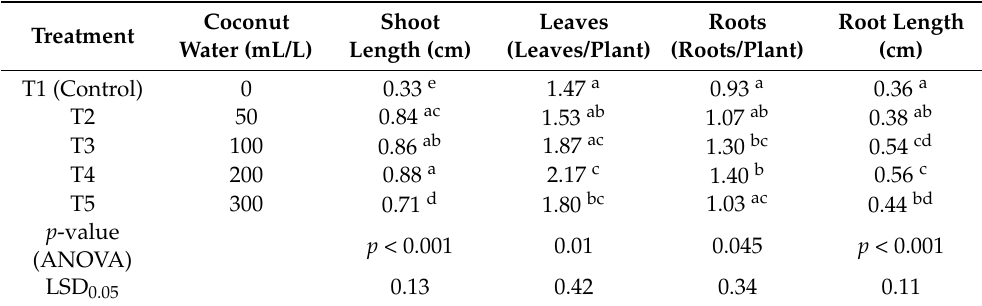
Table 7. Effect of coconut water on the growth and development of D. anosmum Lindl. (6 weeks after